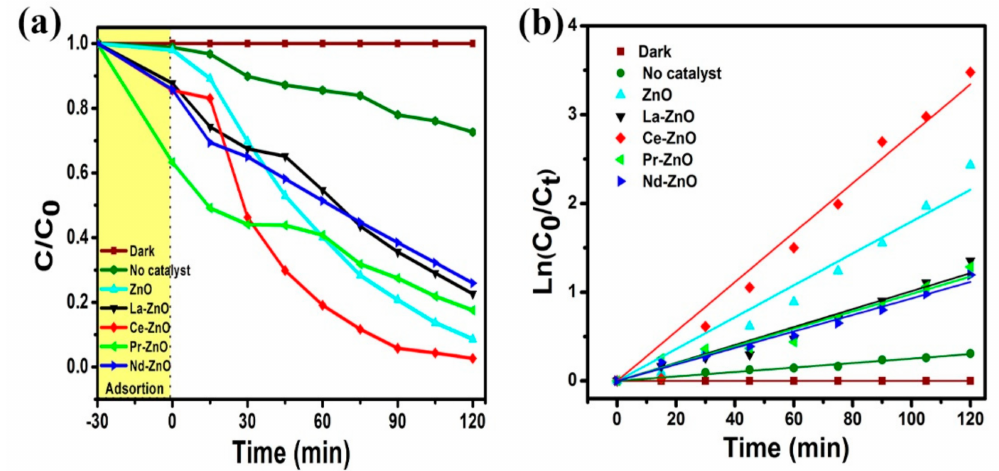
Figure 10. ( a ) The degree of degradation of the RhB dye in each time interval; ( b ) a graph of the kinetics of the degradation of the RhB dye, plotted for the first linear order as Ln(C 0 /C t ) vs. irradiation time (t). Data are given for nanoparticles calcined to 700 ◦